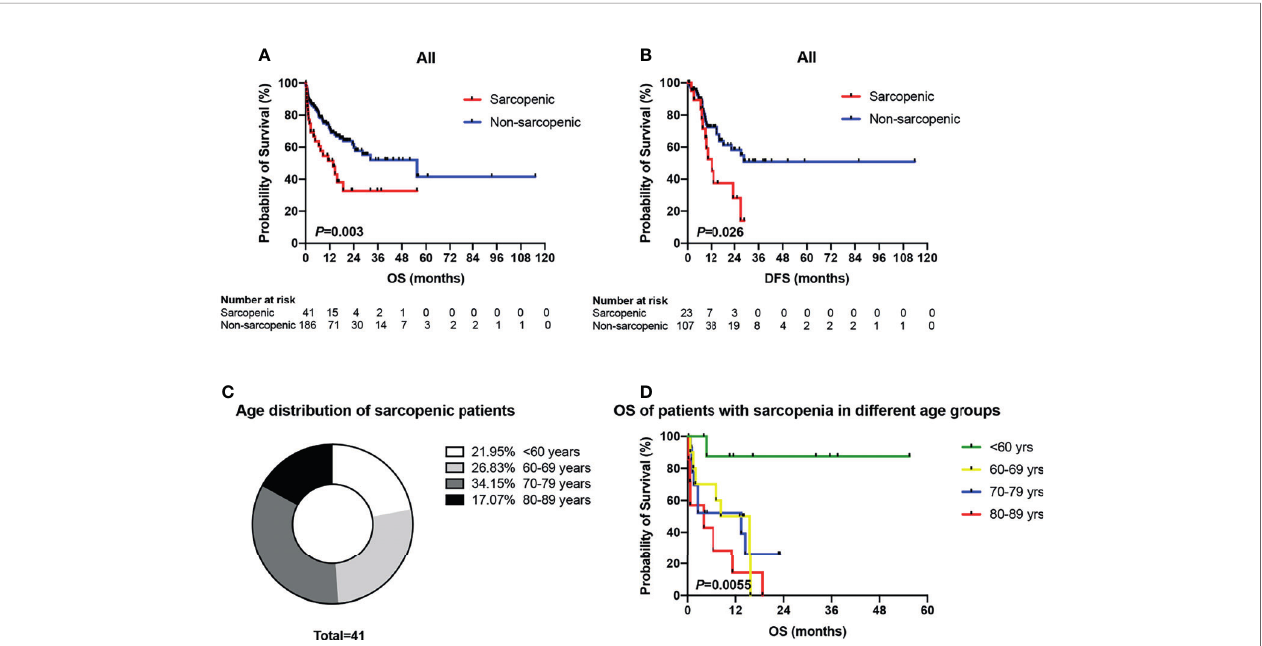
FIGURE 2 | Survival analyses of sarcopenic patients drawn by Kaplan-Meier survival curves. (A) Patients in the sarcopenic group showed statistically shorter OS than non-sarcopenic ones (median OS: 13.7 vs. 55.6 months, P = 0.003). (B) The sarcopenic patients showed signi fi cantly shorter DFS than those with non- sarcopenia (median DFS: 12.5 vs. not reached, P = 0.026). (C) Age distribution of sarcopenic patients. (D) Kaplan-Meier plots for overall survival of sarcopenic patients in different age groups (<60 vs. 60 – 69 vs. 70 – 79 vs. 80 – 89 years). OS, overall survival; DFS, disease-free survival.